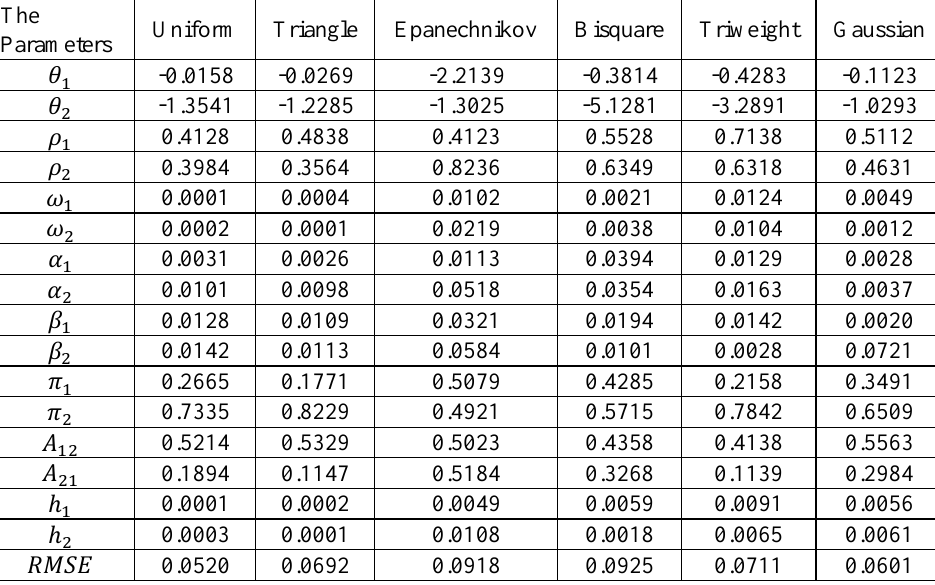
Table 4. The estimated parameters for the Automotive Industry Index data The Uniform Parameters